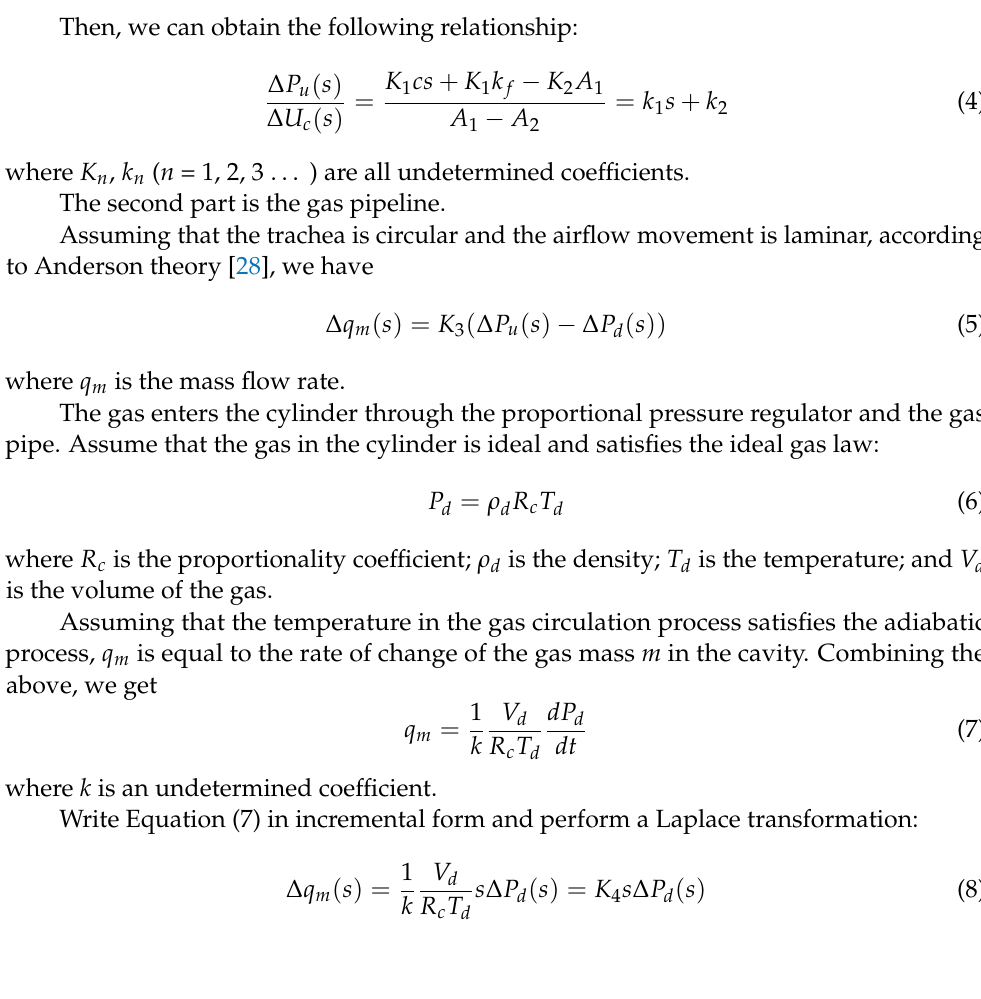
Figure 3. The internal structure of the proportional pressure regulator. (SUP = supply; EXH = exhaust; and OUT = output).